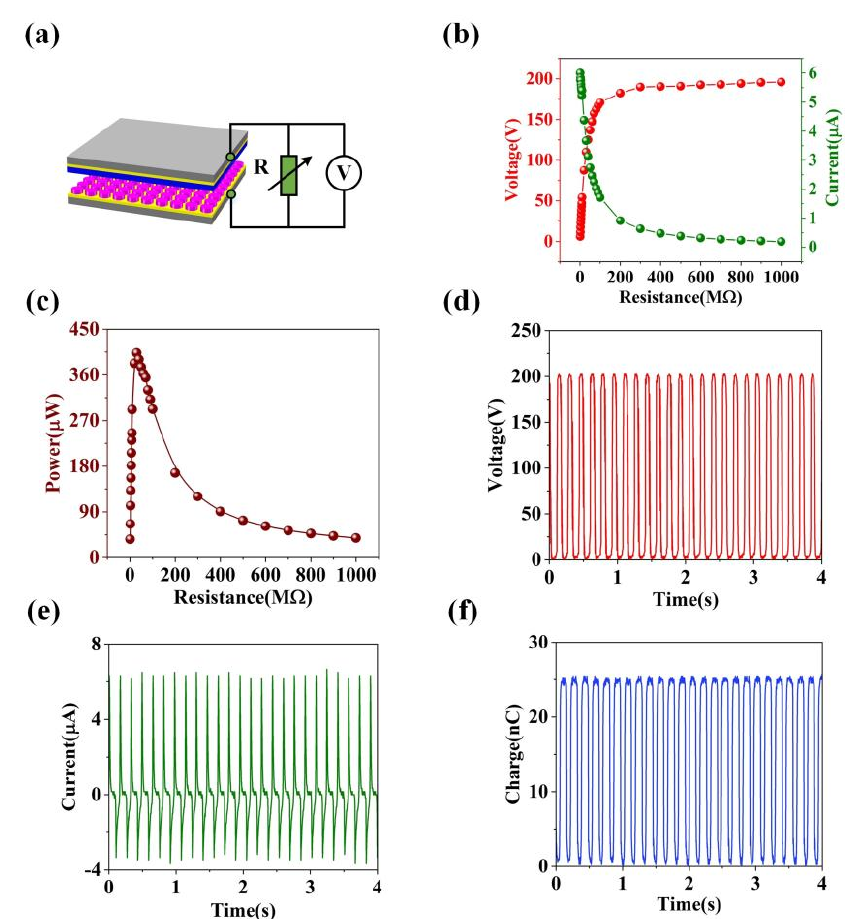
Figure 3. ( a ) The schematic diagram of electrical performance testing system about the S- TENG. ( b , c ) The relation between S-TENG output and resistance of loads. ( d ) I sc , ( e ) V oc and ( f ) charge transfer in the external circuit of